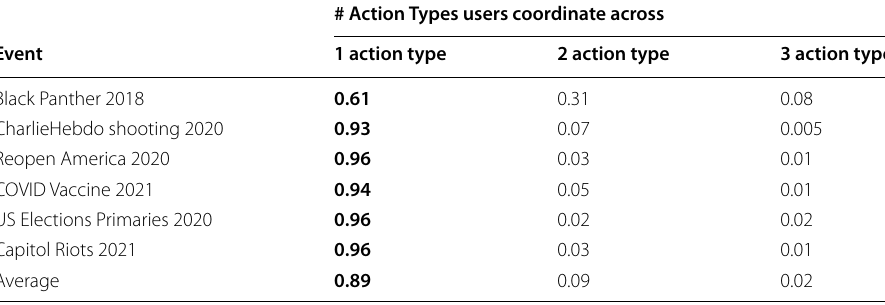
Values in Bold indicate the highest proportion of users across the different action